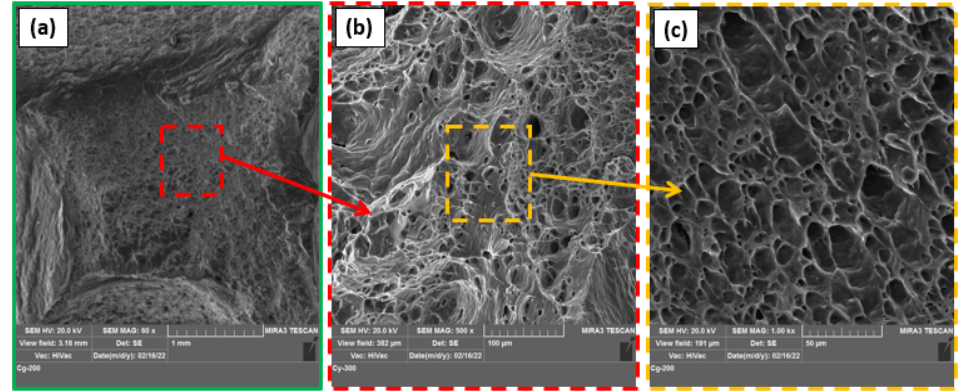
Figure 6. ( a ), ( b ) and ( c ) SEM images of the fracture surfaces for the BT friction stir processed at 200 mm/min using Cy pin geometry at different magnifications.